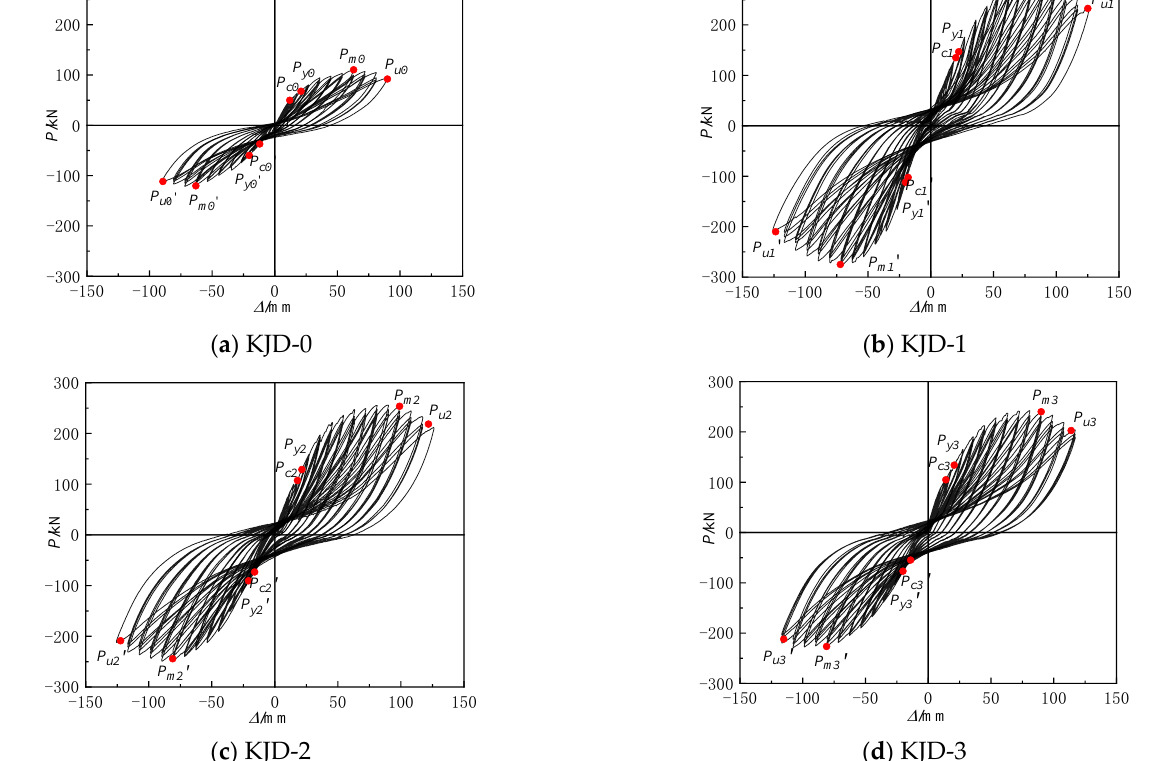
Figure 9. Hysteretic loops of specimens. ( a – d ). Note: For KJD-0, P c represents the cracking point of concrete; For KJD-1 ~ KJD-3, P c represents the cracking point of surface glue; P y , P m and P u represent the yield point, peak point and limit point, respectively.